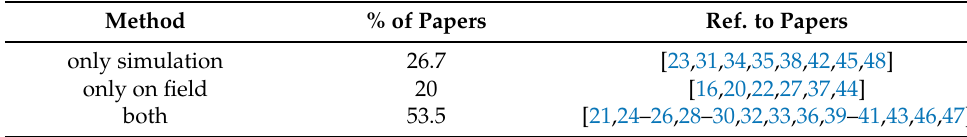
Table 12. Method of testing.